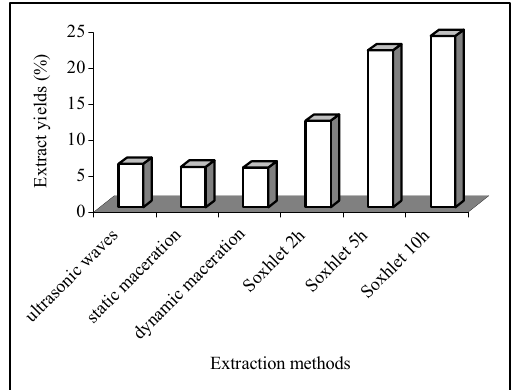
Fig. 3 – Extract yields (%) of the crude chloroform extracts from roots of Plumbago scandens L. obtained by different extraction techniques.